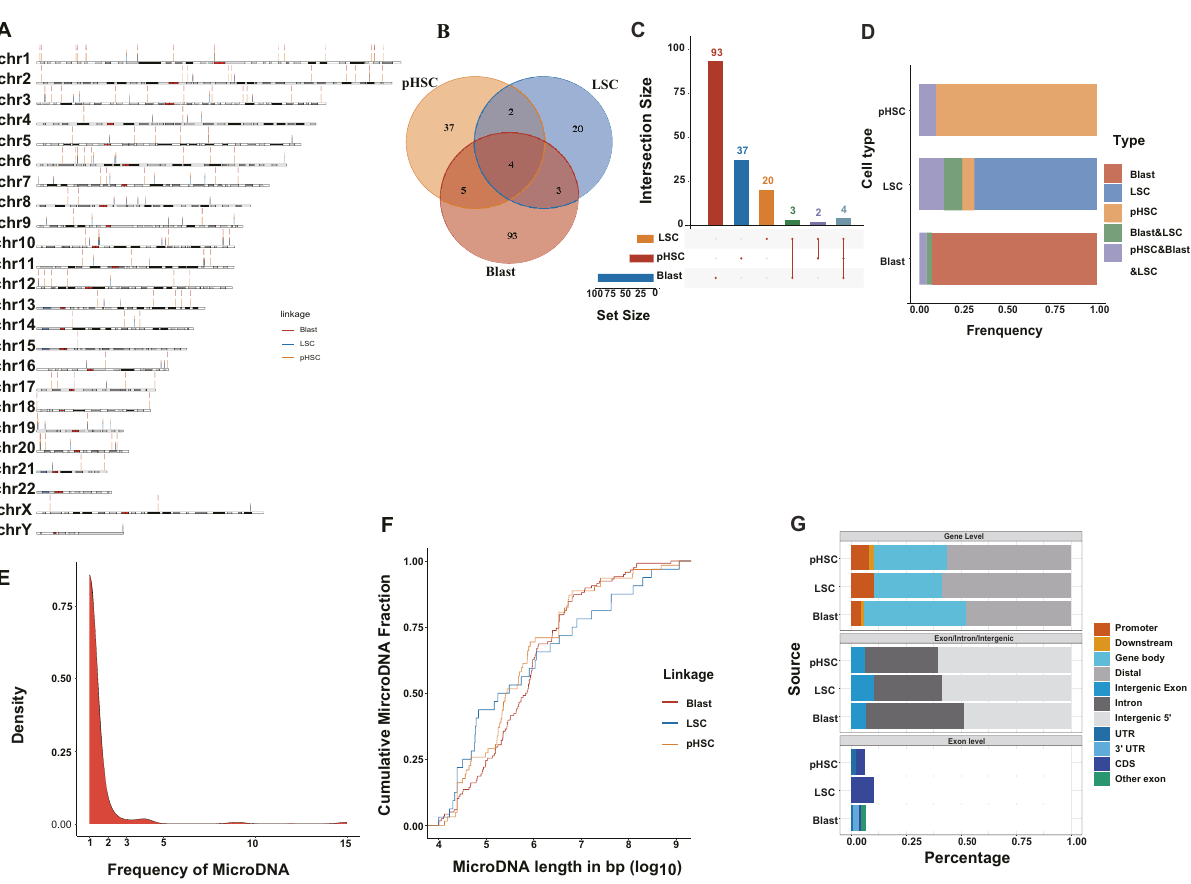
Fig. 5 microDNA in pHSC, LSC, and blast. A Chromosome ideogram plot showed the microDNA distribution of pHSC, LSC, and blast. B Venn diagram of overlapping microDNA. C The barplot identi fi ed the microDNA number in the overlap of different cells. X-axis represents the cell type; Y-axis represents the number of microDNA. D The frequency of overlapping microDNA in pHSC, LSC, and blast, respectively. X-axis represents the cell type; Y-axis represents the intersection size. E Frequency distribution graph showed that more than 80% microDNA only appeared once in pHSC, LSC, and blast. F Length distribution of identi fi ed microDNA in pHSC, LSC, and blast. G Peak distribution over different genomic features. At gene level, ~50% microDNAs were mianly enriched in promoter, downstream, and gene body. At the exon/ intron/intergenic level, most microDNAs were enriched in intron and intergenic regions. At exon level, microDNAs of pHSC were mainly enriched in 5 ′ UTR and CDS, microDNAs of LSC were mainly enriched in CDS. While microDNAs of blast were enriched in 3 ′ UTR and other exon.